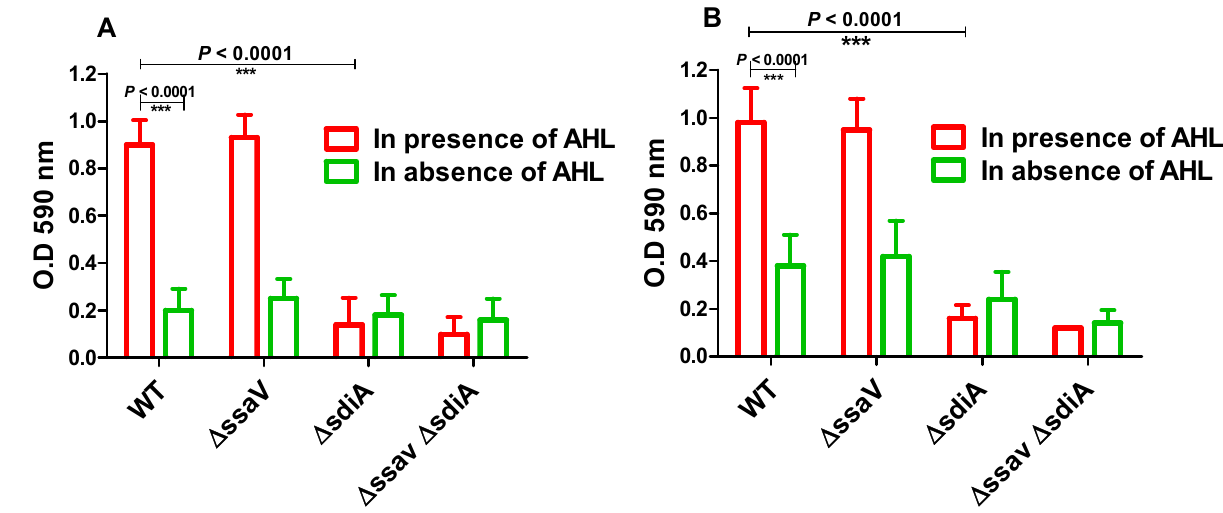
Figure 4. Bacterial adhesion to abiotic surface and biofilm formation. S. enterica WT, ∆ ssaV , ∆ sdiA and ∆ ssaV ∆ sdiA were cultured in presence or absence of AHL in polystyrene microtiter plate and incubated at 37 ◦ C, either for 1 h (for evaluation of adhesion) or for 24 h (for evaluation of biofilm formation). ( A ) Adhering cells or ( B ) Biofilm forming cells were stained by crystal violet, ethanol was added and optical density was measured at 590 nm. Assays were performed in triplicate, and results were expressed as means ± standard deviations; p -value < 0.05 was considered statistically significant, using a two-tailed t-test (*** = p < 0.001)